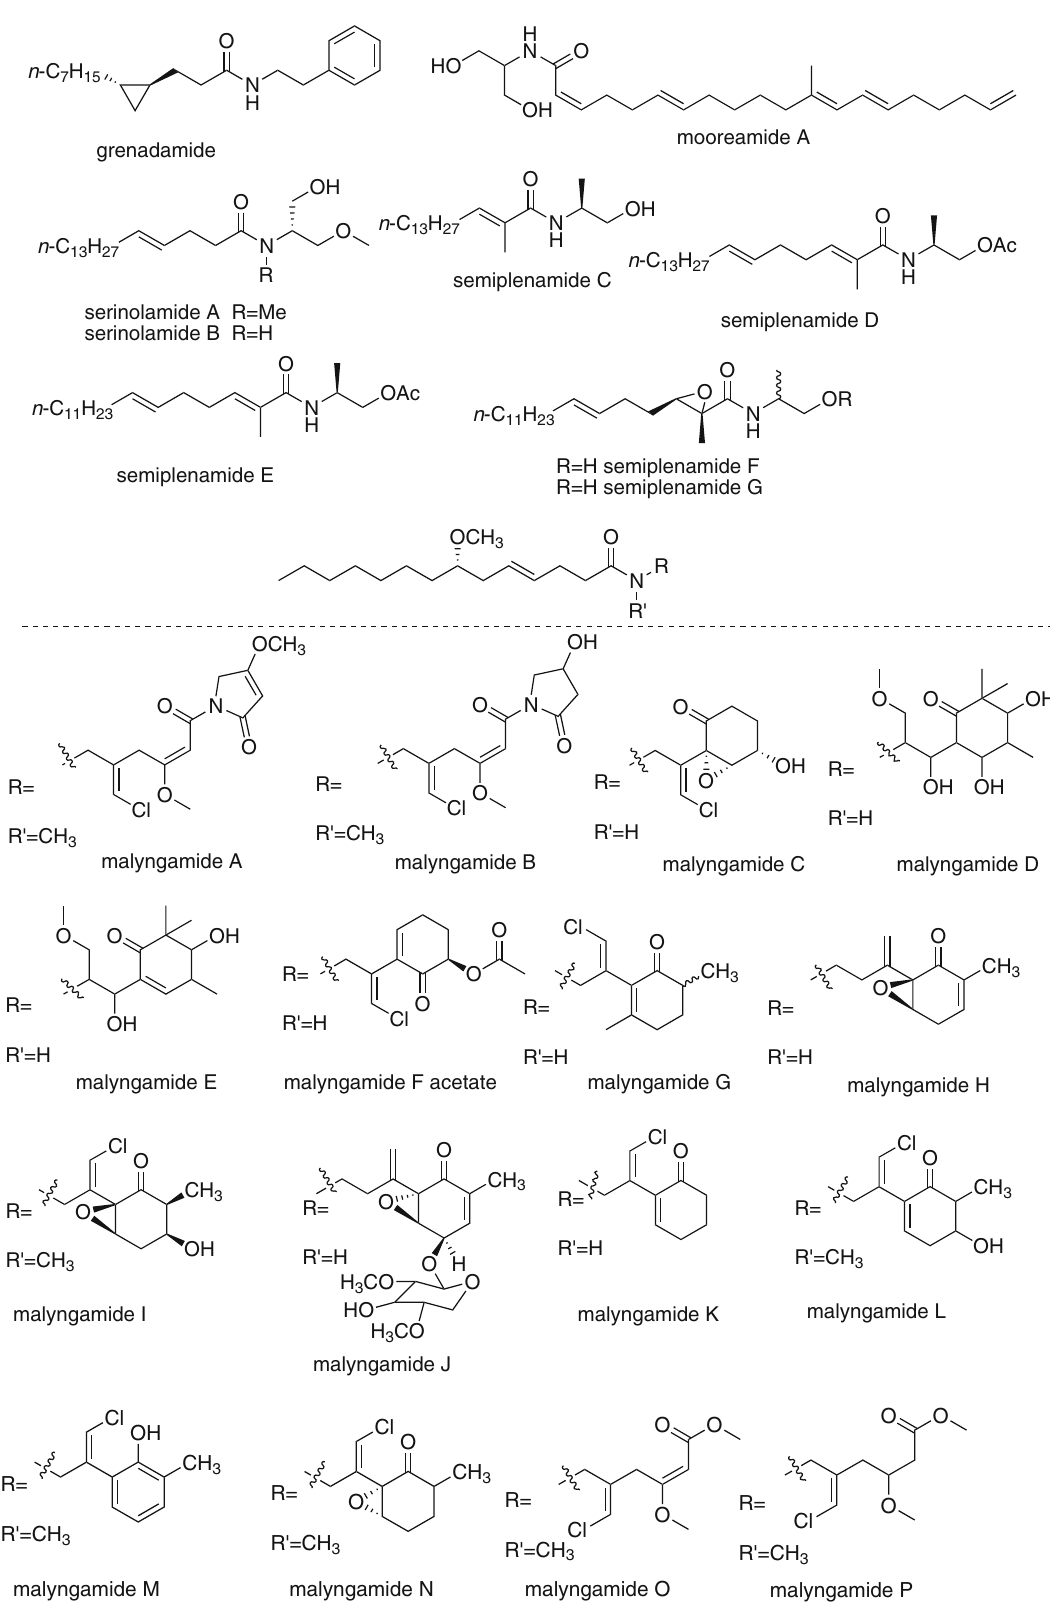
Fig. 2 The structures of cannabinomimetric